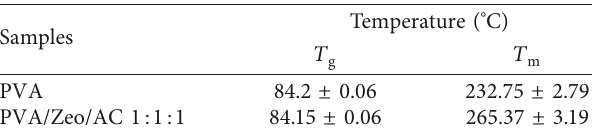
Table 2: Thermal characteristics of PVA and several PVA/Zeo/AC